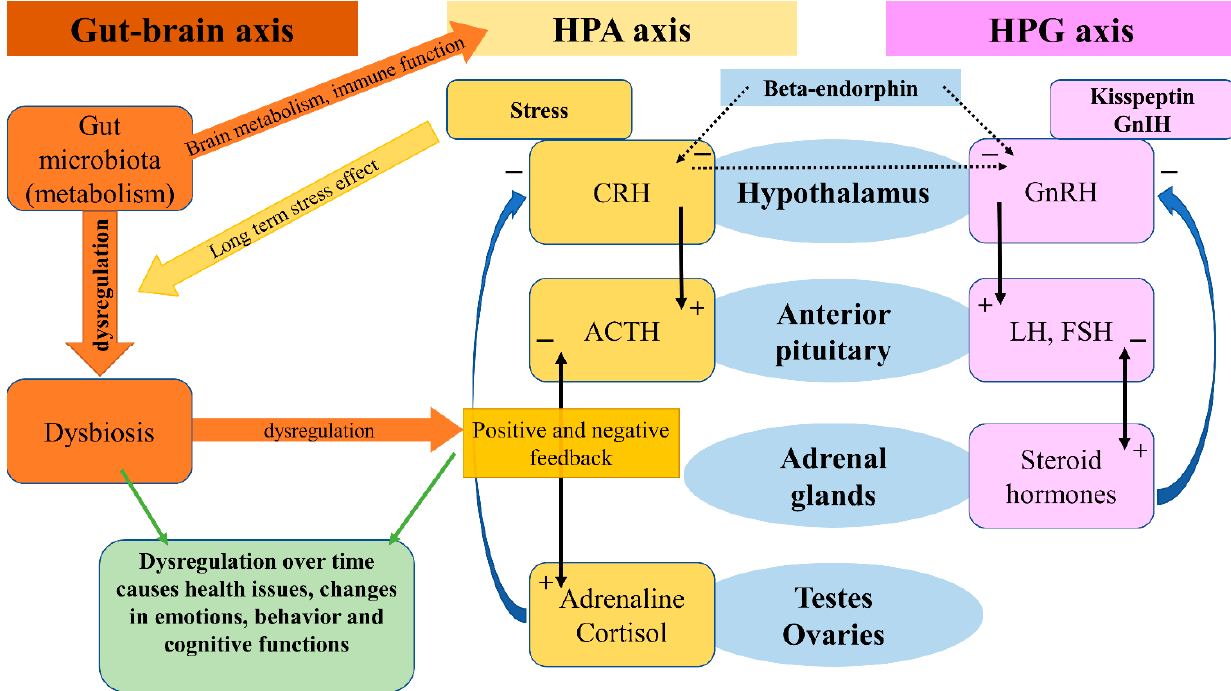
Figure 2. Gut-brain axis, HPA axis, HPG axis and their interactions.